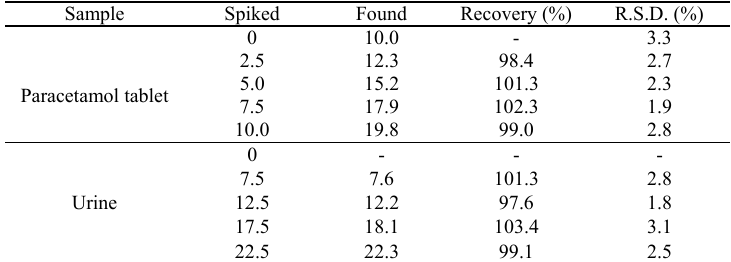
Table 1. The application of Cu/SPE for determination of paracetamol in paracetamol tablet and urine samples (n=5). All concentrations are in µM.